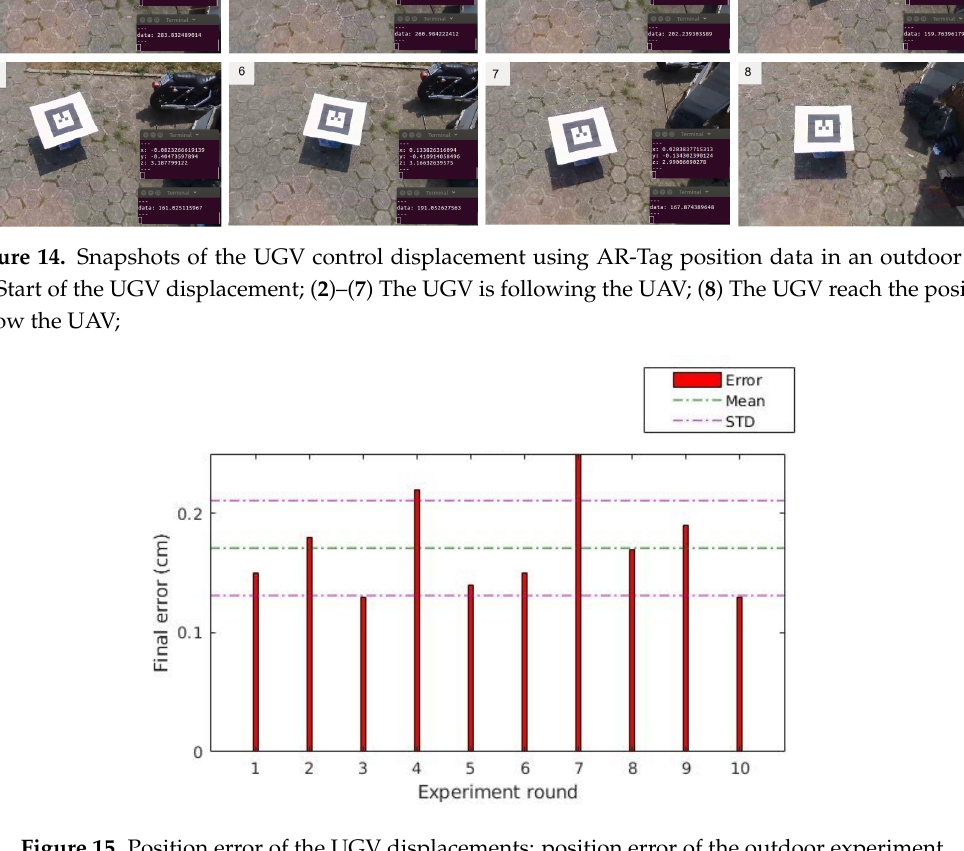
Figure 15. Position error of the UGV displacements: position error of the outdoor